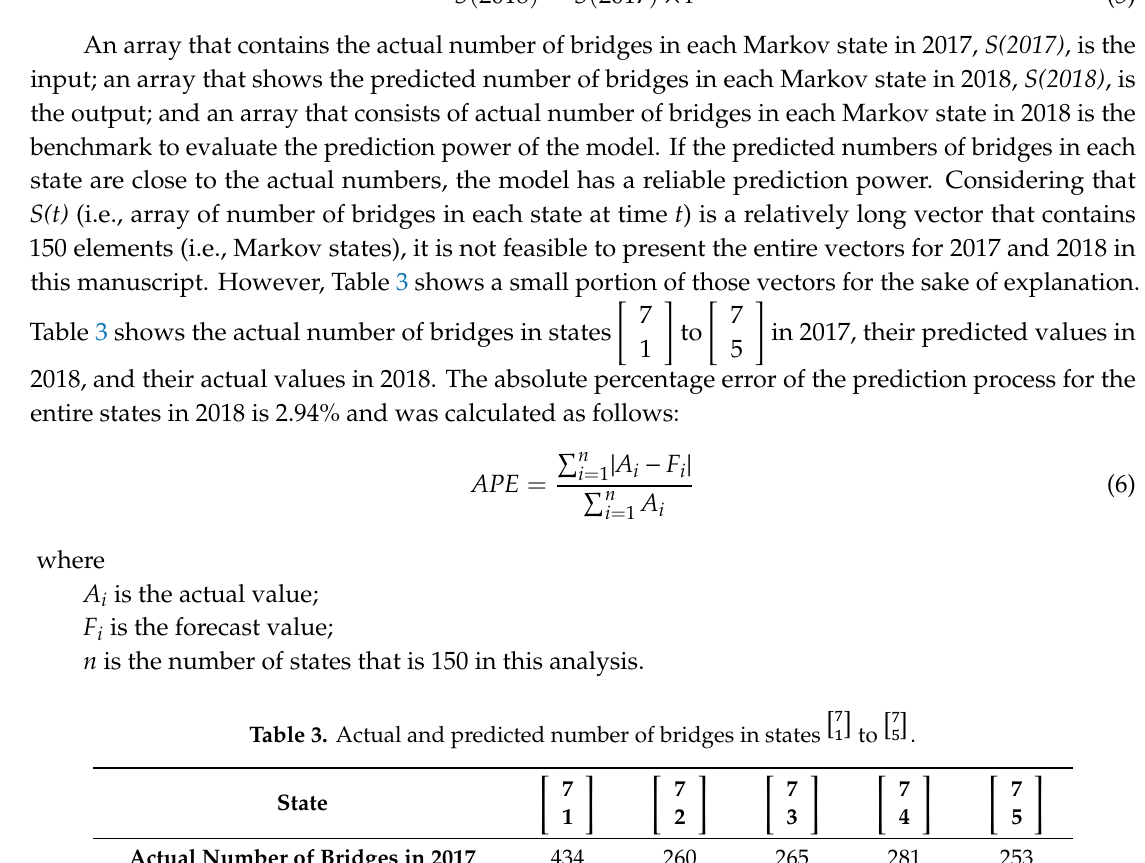
Table 3. Actual and predicted number of bridges in states (cid:3427) (cid:2875) (cid:3431) to (cid:3427) (cid:2875) (cid:3431) (cid:2869) (cid:2873)